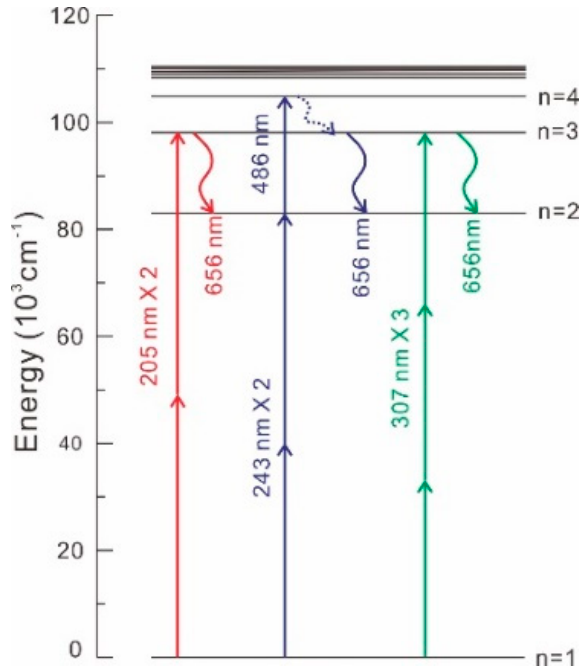
Figure 2. Excitation and detection strategy of atomic hydrogen using the multiphoton femtosecond laser-induced fluorescence (MP-fs-LIF).